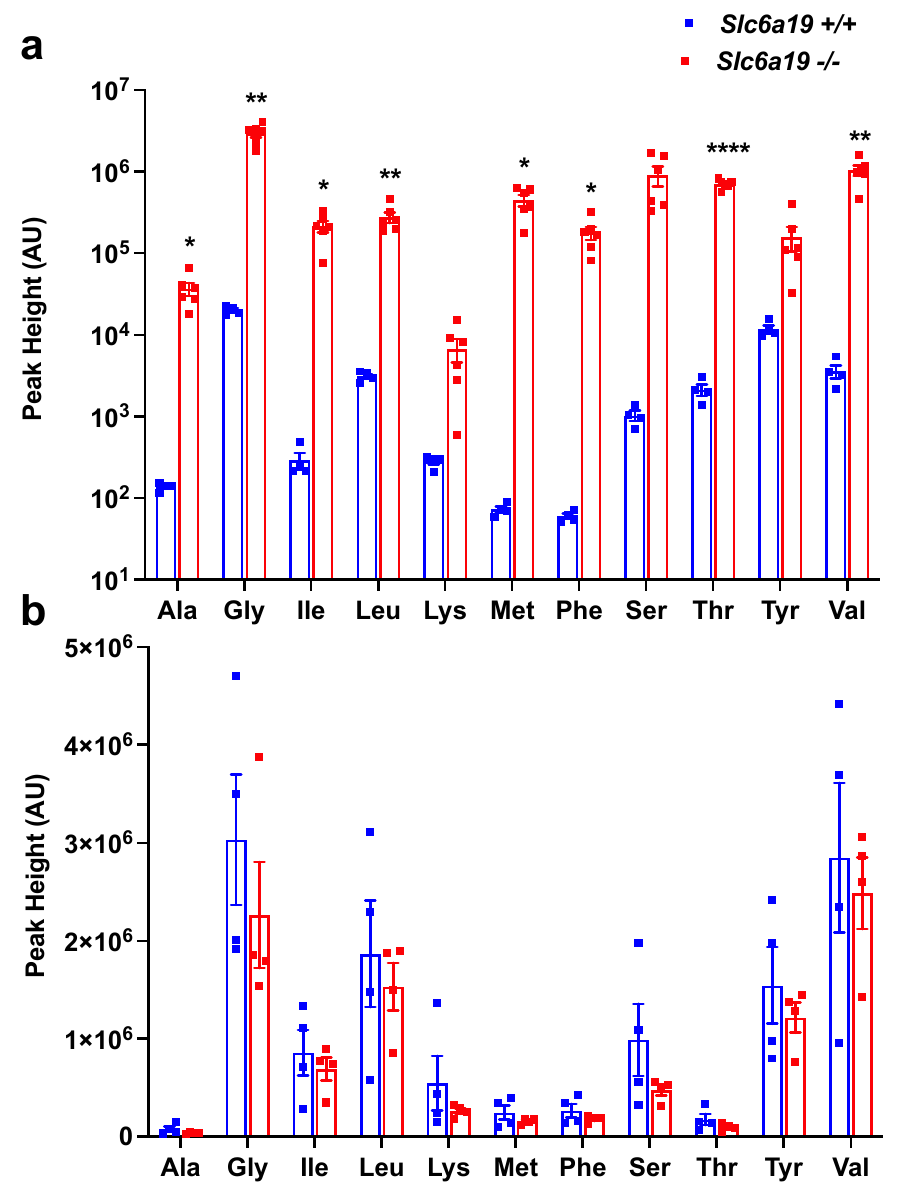
Figure 1. Slc6a19 deficiency caused marked aminoaciduria in NOD mice. ( a ) Amino acid abundance measured in urine normalised to osmolality. ( b ) Plasma amino acid abundance. Samples were collected in the morning from mice 6–8 weeks of age, stored at − 80 °C. Amino acid abundance is presented as peak height in arbitrary units (AU). All results are presented as mean ± SEM; * p < 0.05, ** p < 0.01, **** p < 0.0001 Slc6a19 +/+ versus Slc6a19 − / − ; n = 4–6 mice/genotype.